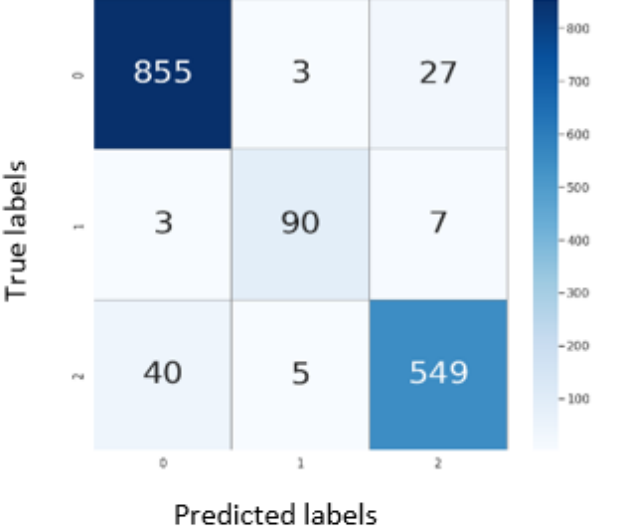
Figure 4. Confusion matrix for the evaluation on test set of COVIDx dataset, where the labels 0, 1, and 2 represents the normal, COVID-19, and pneumonia classes, respectively.